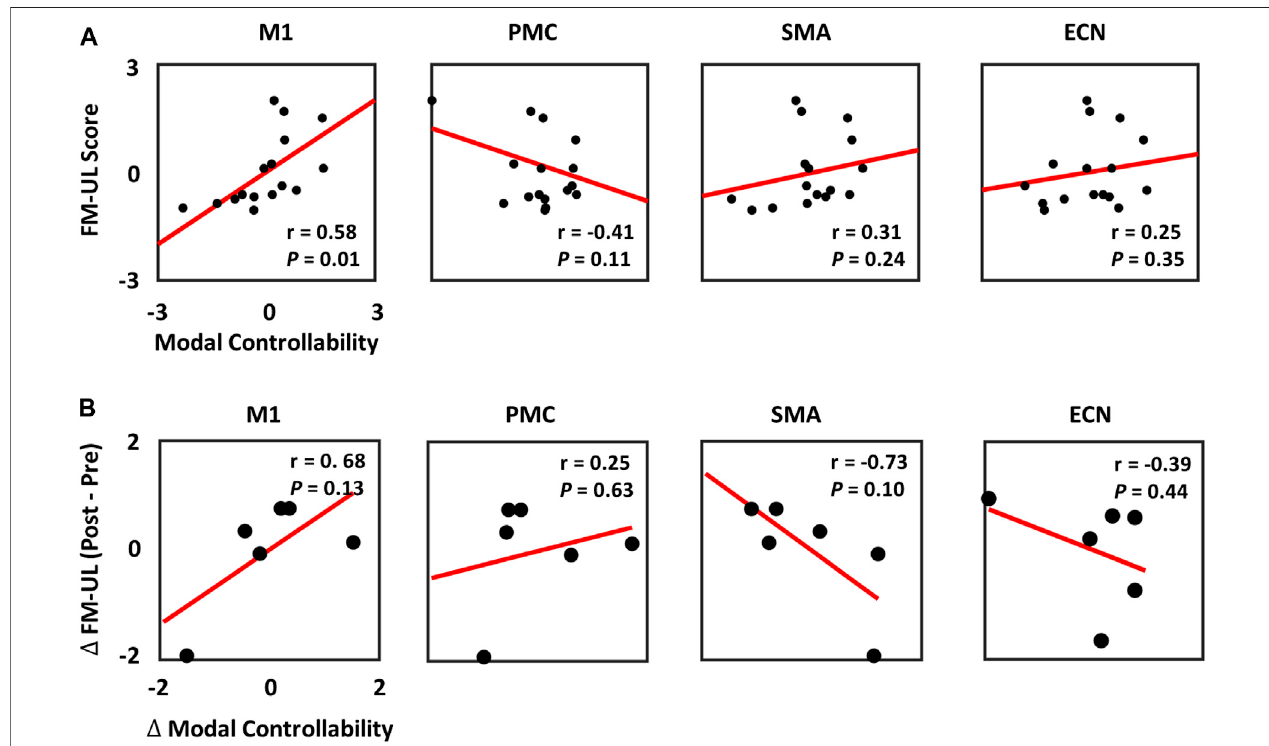
FIGURE 5 | (A) Relationship between the baseline FM-UL scores and the baselinemodal controllability in M1, PMC, SMA, and ECN. (B) Relationship between the changes of FM-UL scores and the changes of modal controllability at pre- and post-intervention among the 6 stroke patients.